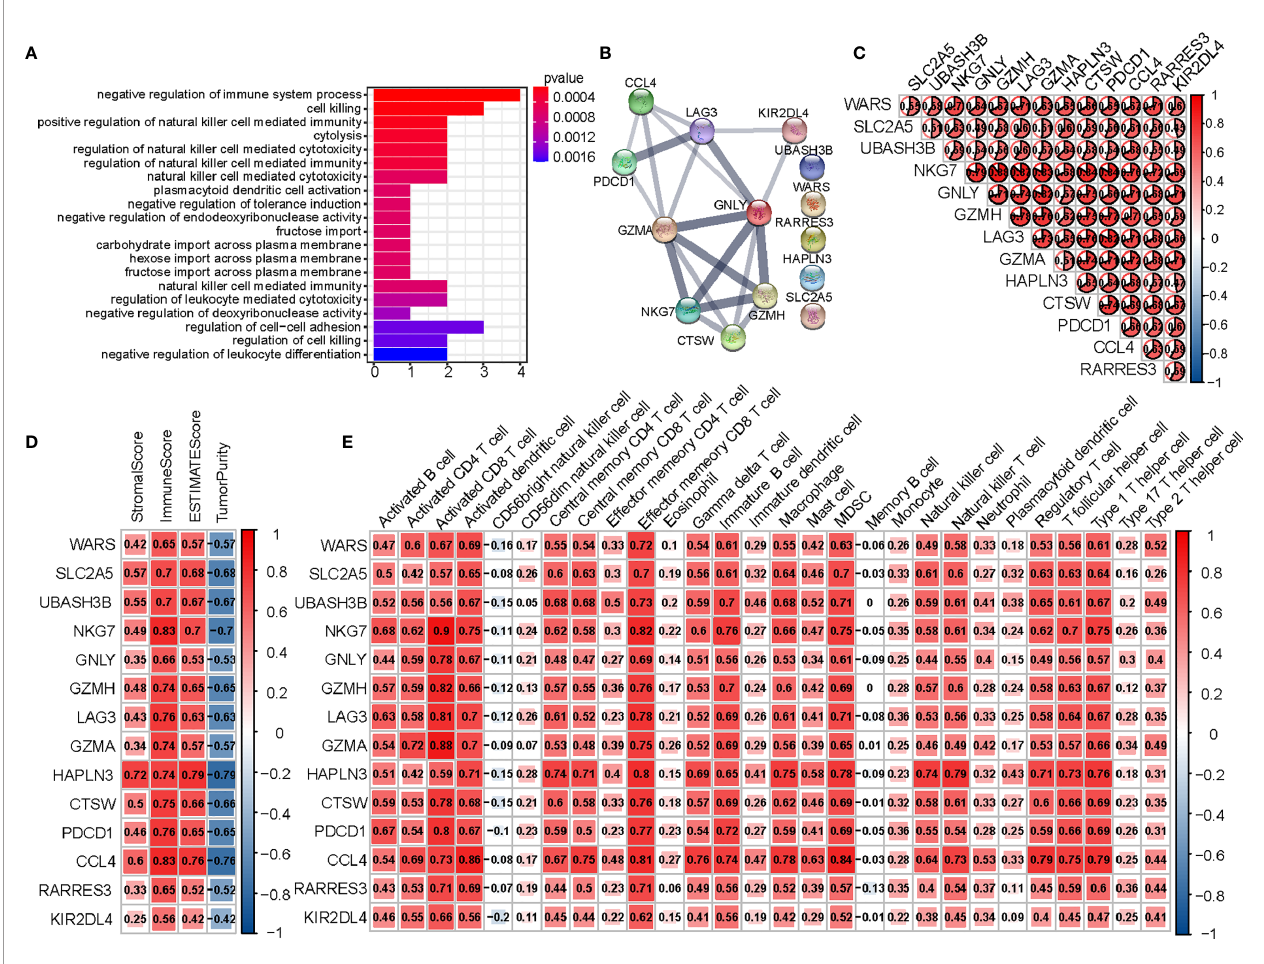
FIGURE 6 | Analysis of 14 hub genes. (A) The GO analysis of hub genes. (B) PPI network of hub genes. (C) Correlation between hub genes. (D) Correlation between hub genes and results of ESTIMATE. (E) Correlation between hub genes and expression of immune cells